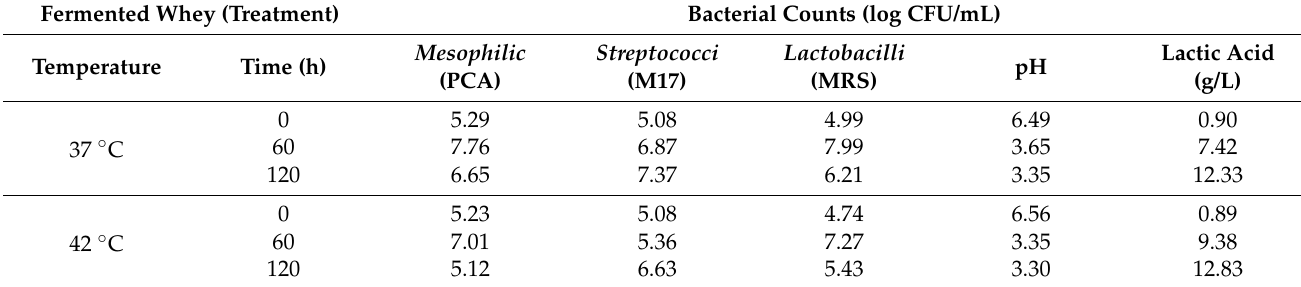
Table 1. Bacterial counts, pH, and lactic acid content in whey fermented at different temperatures and times.